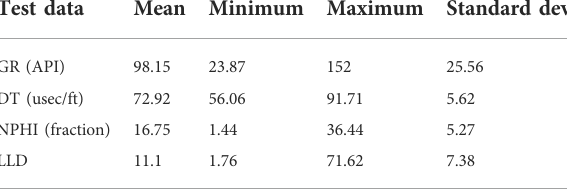
TABLE 3 Statistical description of the test data (Kadanwari-03).